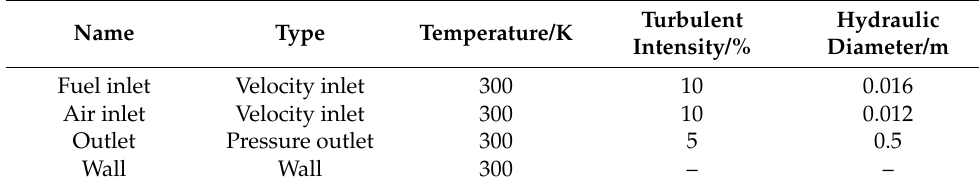
Figure 7. Calculation of yellow flame coefficient of mixture.